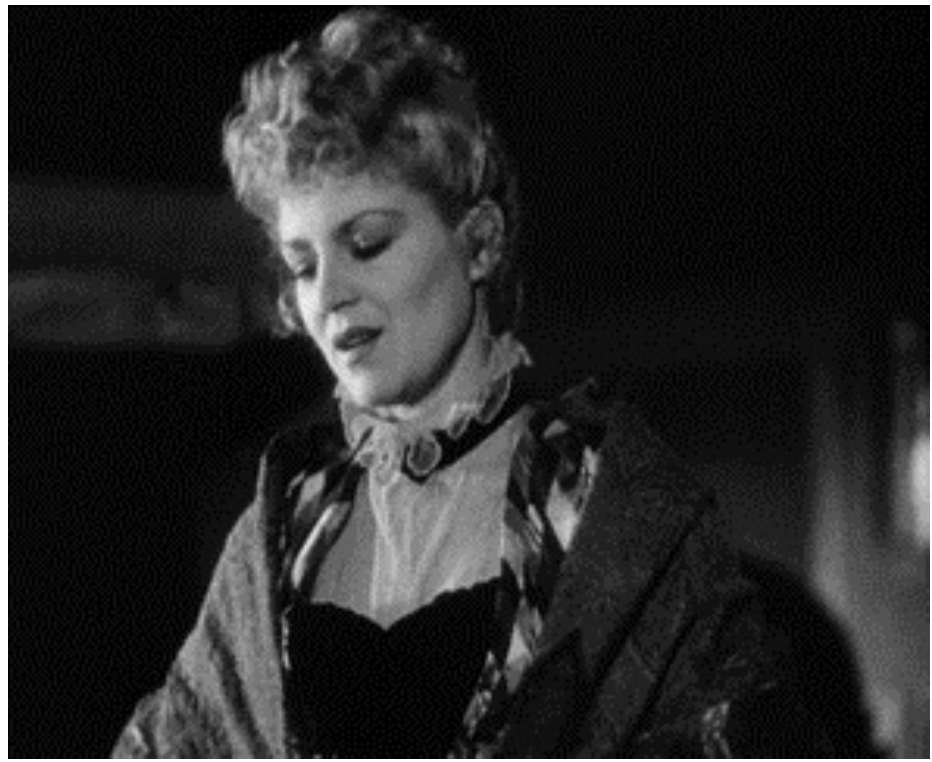
Figure 11: Script: Dallas looks down at Lucy sympathetically. DALLAS: ‘I know’